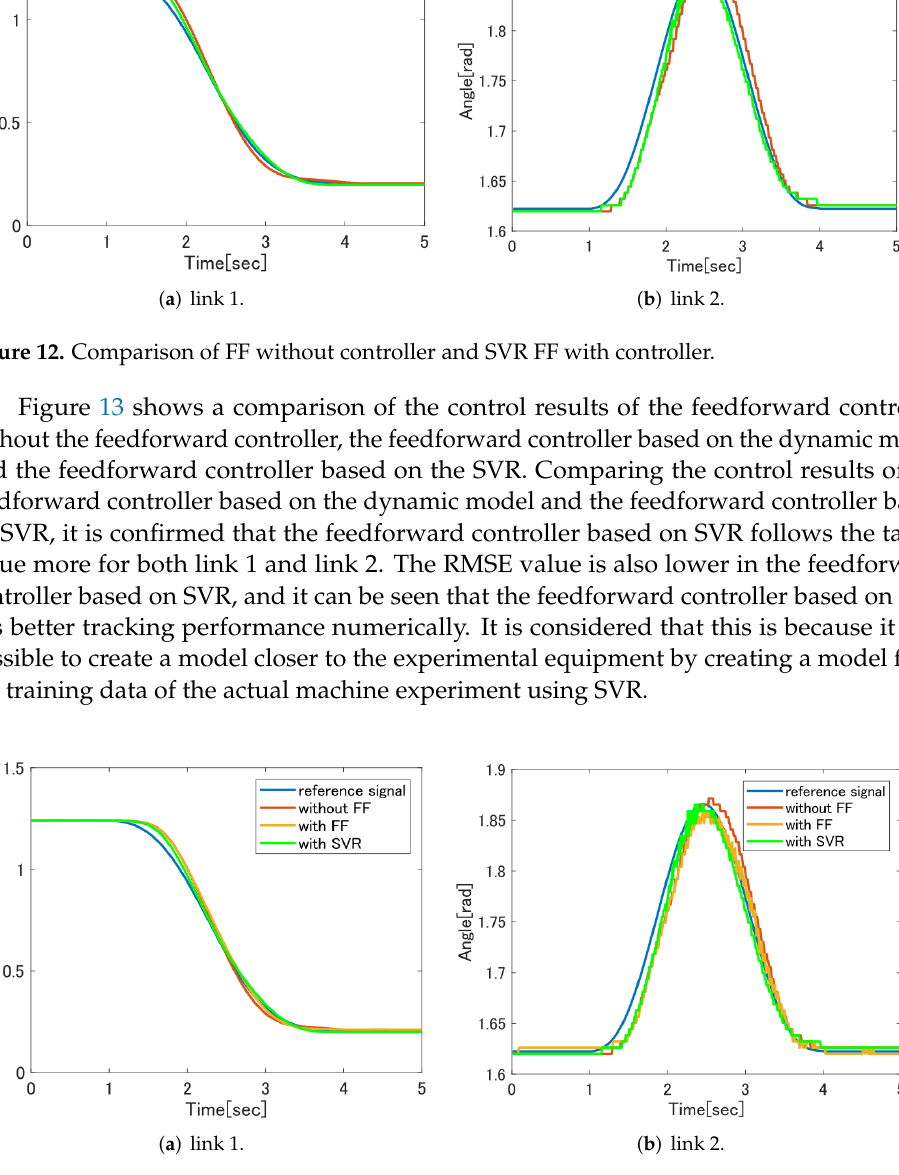
Figure 13. Comparison of all control